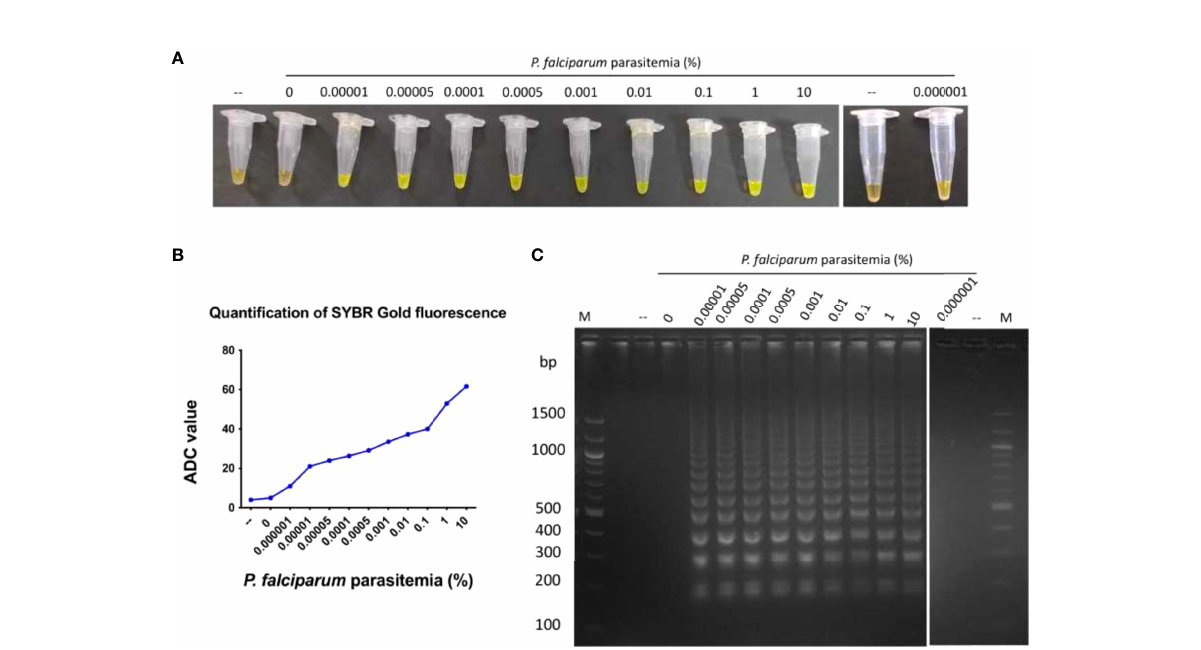
FIGURE 3 Limit of detection of P. falciparum genomic DNA ampli fi ed in the LAMP device.DNA isolated from P. falciparum cultures containing 0.000001 to 10% parasitemia was used in a LAMP reaction for 100 minutes, as described in Materials and Methods. As a control, DNA isolated from a sample containing zero parasitemia, i.e. only blood, was also tested in the LAMP reaction. (A) The con fi rmation of LAMP ampli fi cation was done by SYBR Gold detection. Diluted SYBR Gold nucleic acid stain was added to the LAMP products, and the color change was detected by visual examination. – : non-template control. (B) The quanti fi cation of SYBR Gold fl uorescence was done by measuring the fl uorescence intensity of the samples by a detection device, designated as ADC values. The mean + SEM of 10 ADC values are plotted for each sample. (C) Electrophoresis of LAMP products on a 2.5% agarose gel. M: 100 bp DNA